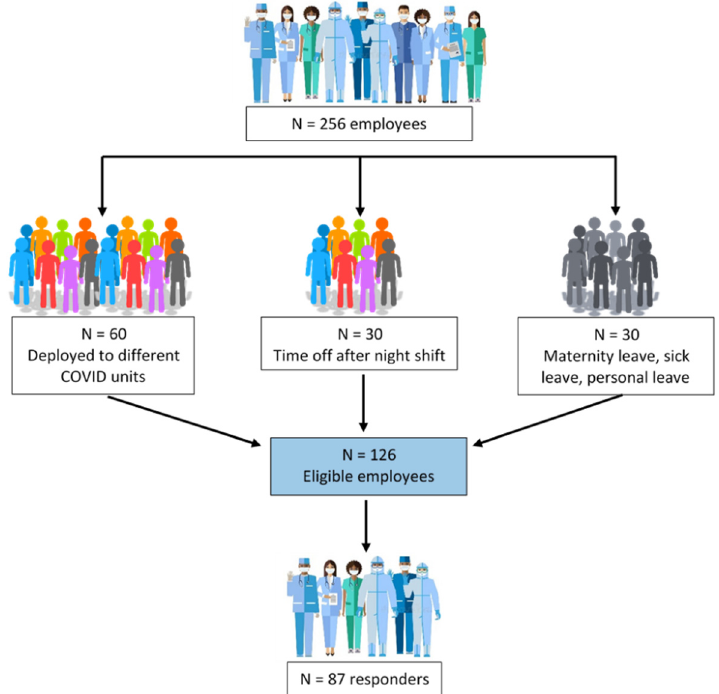
Figure 1. Enrollment flowchart. Table 1. Descriptive statistics of age, working years, and COVID time for the studied groups. YRS-years Min—Minimum; Max—Maximum; SD—Standard Deviation; IQR—Inter Quartile Range; *—statistically